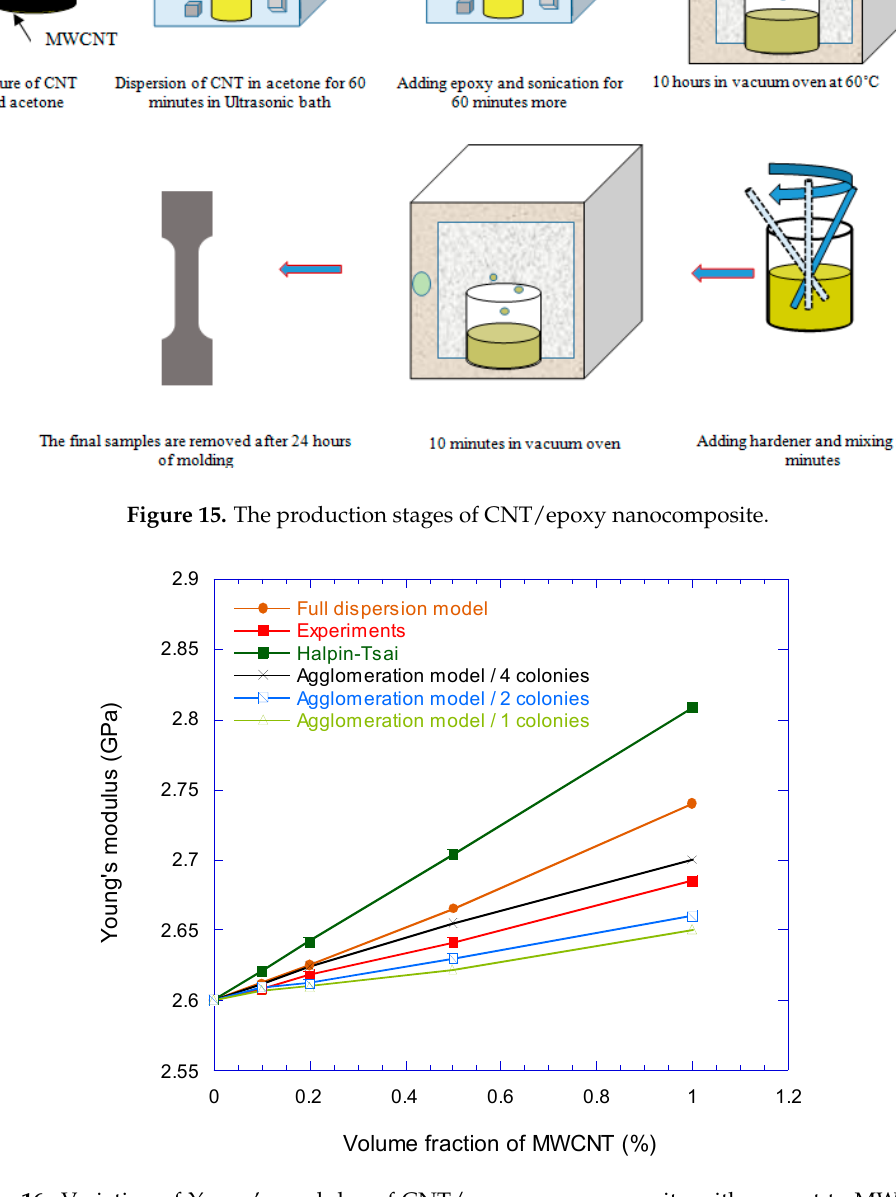
Figure 16. Variation of Young’s modulus of CNT/epoxy nanocomposite with respect to MWCNT volume fraction.